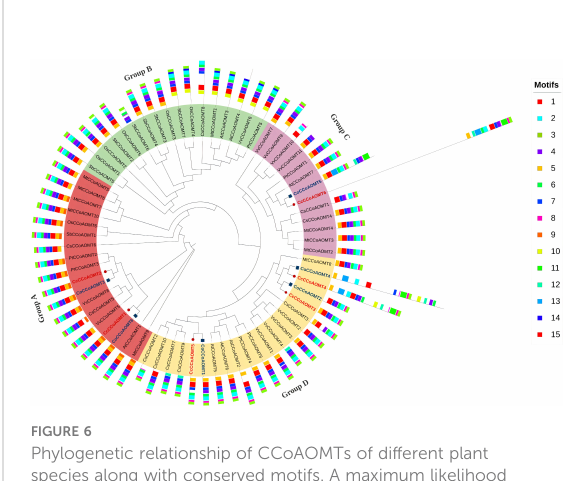
Table 2). Interestingly, one of the C. capsularis genes ( CcCCoAOMT5 ) appears to be a part of a syntenic block that extends from Chr04 to Chr02 of C. olitorius . This likely indicates a translocation event at this genomic region, leading to both